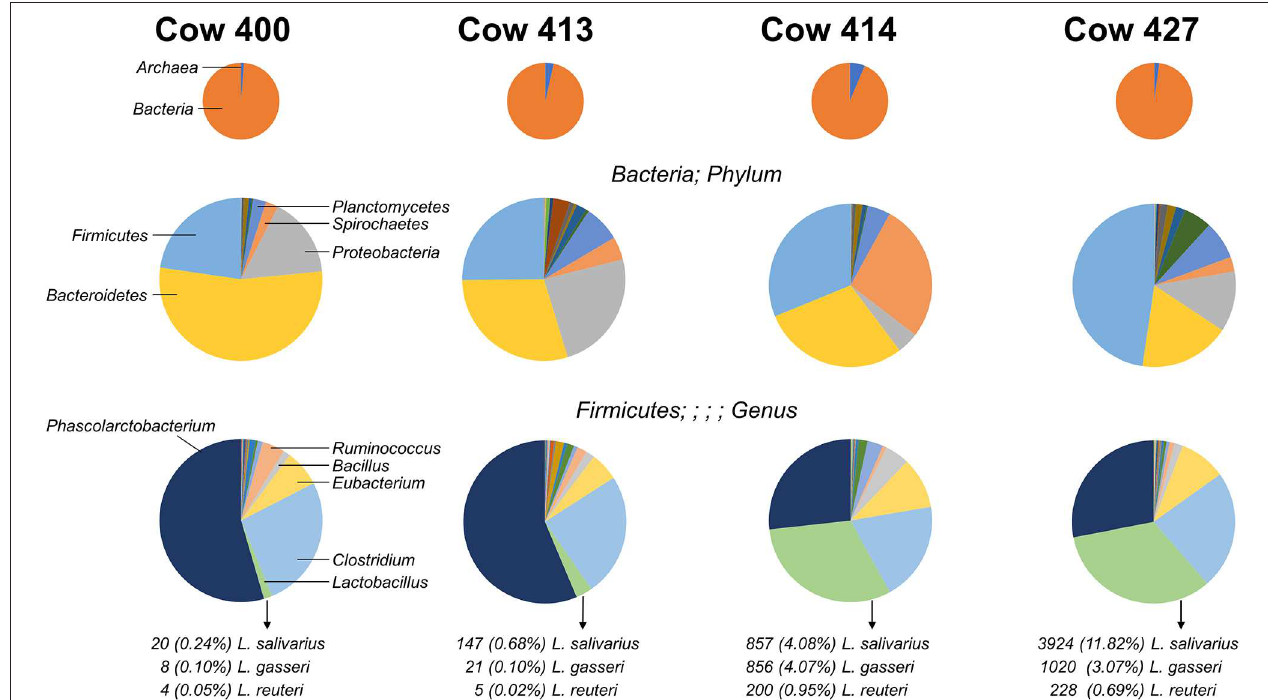
FIGURE 1 | Distribution of microbes identified from four cow fecal samples. Pie charts indicate the organism distribution at the kingdom level (Top) , the bacteria distribution at the phylum level (Middle) , and the Firmicutes distribution at the genus level (Bottom) . The chart data are arranged from largest to smallest count for the combined total of the four cows, and the highest-ranking members are noted (left charts). The count and percentage of isolated Lactobacillus species are listed.